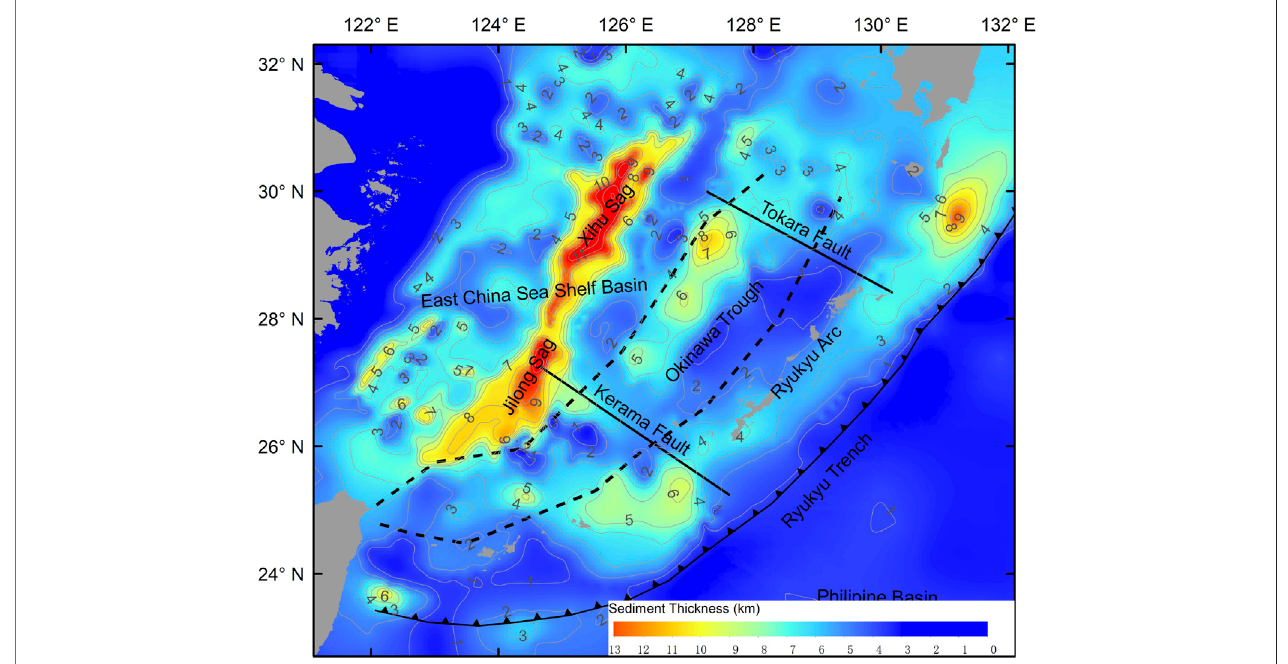
FIGURE2| Thethickness mapofthesedimentarylayerinourstudyarea.Thegridiscreated via Kriginginterpolationmethodbasedontheglobalmarinesediment thicknessgrid(Straumeetal.,2019)andrecentinterpretationresultsofseismicre fl ectiondata(Fangetal.,2020).Theblackdashedlinesrepresenttheboundariesofthe Okinawa Trough.